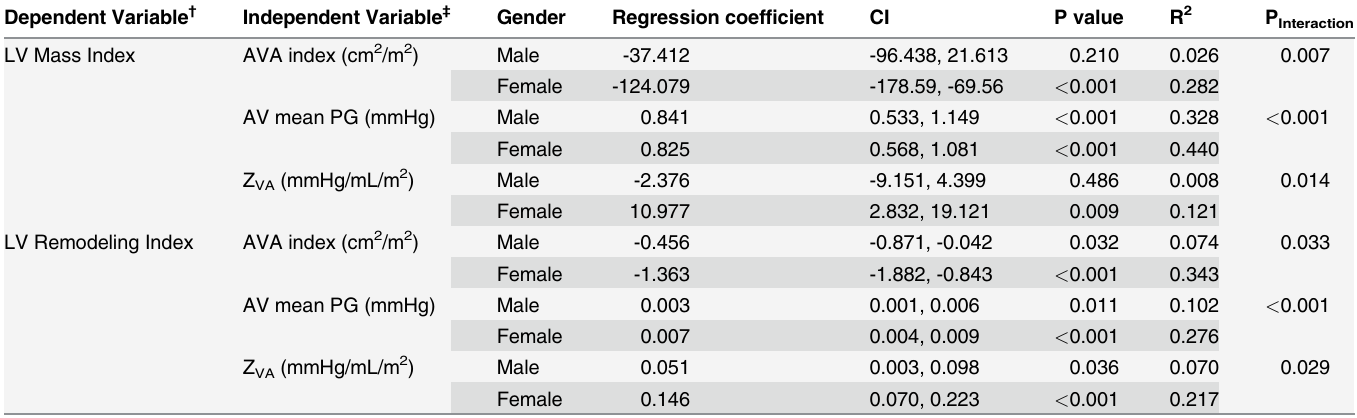
Table 3. Univariate analysis of the association and gender-specific interaction between the indexed left ventricular mass or remodeling index and parameters of aortic stenosis